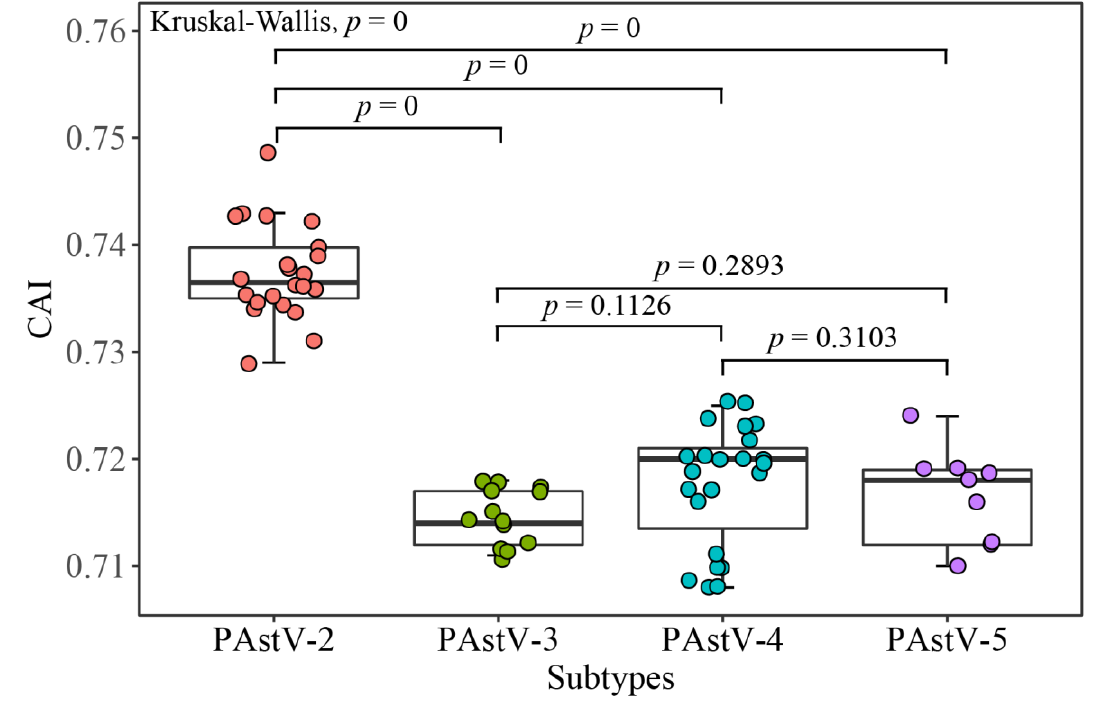
Figure 7. Codon adaptation index (CAI) of the PAstV complete coding genomes. PAstV-2, PAstV-3, PAstV-4, and PAstV-5 strains are represented in orange, green, blue, and purple, respectively.